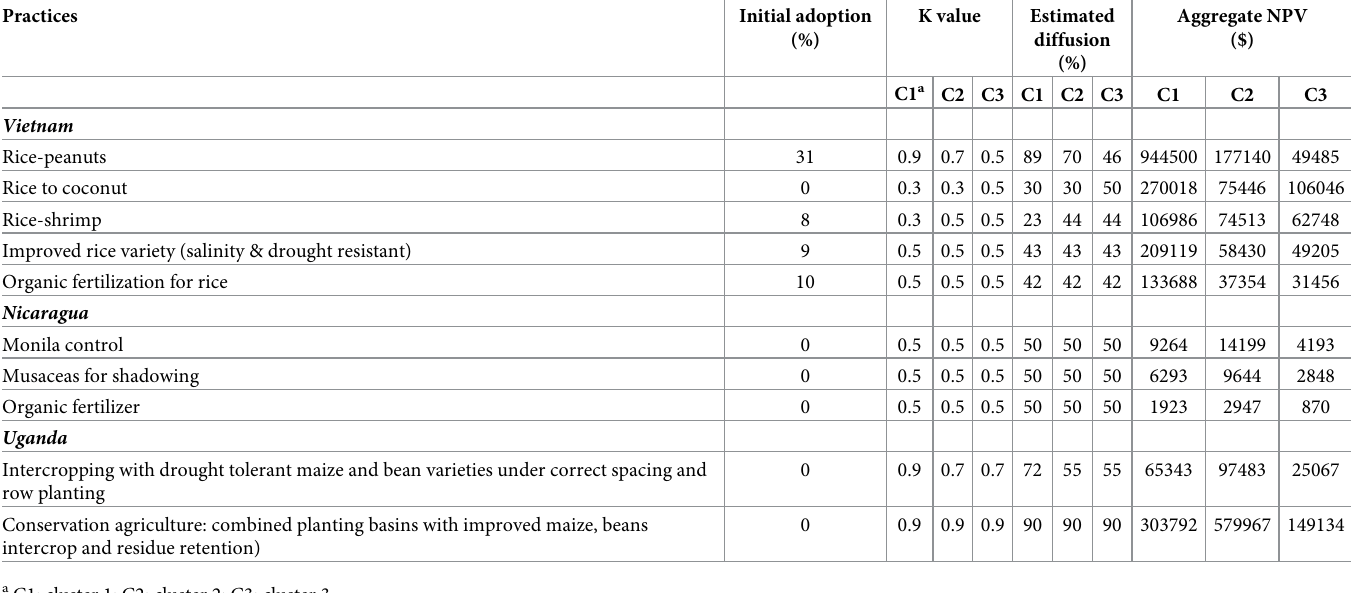
Table 7. Projected adoption rate and aggregate impact using K